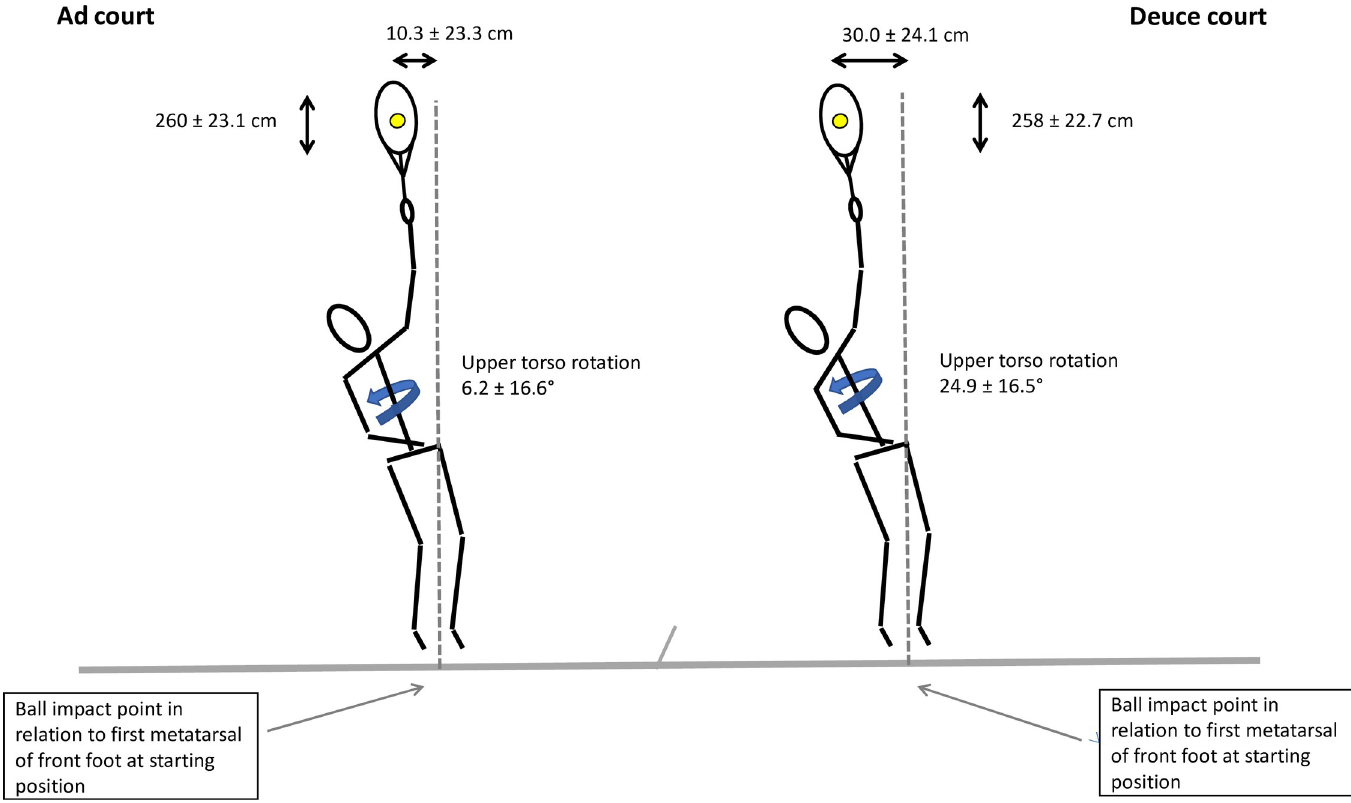
Fig 4. Mean ball displacement and upper torso rotation at